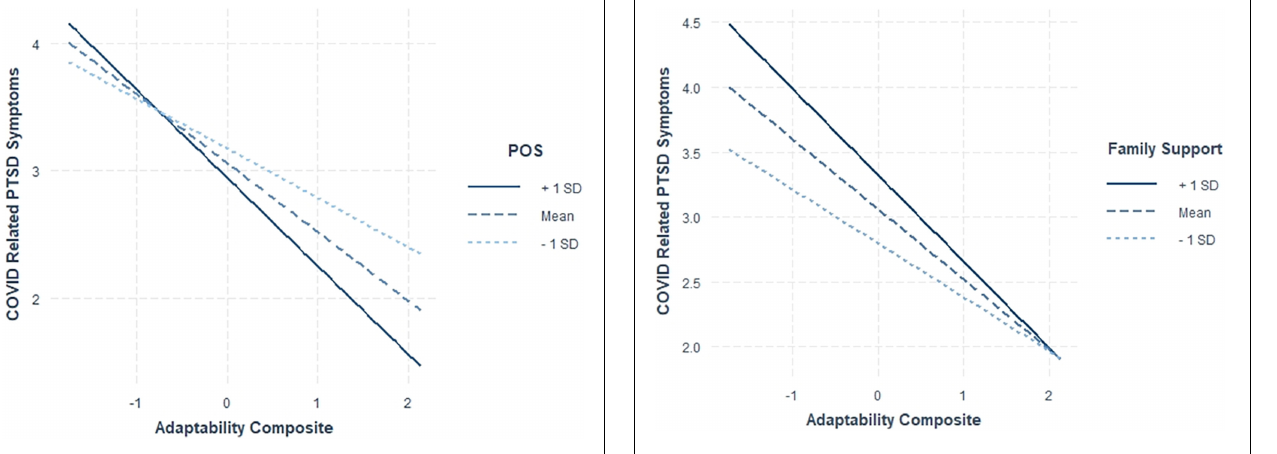
FIGURE 4 | Interaction between adaptability and family support on COVID-19-PTSD